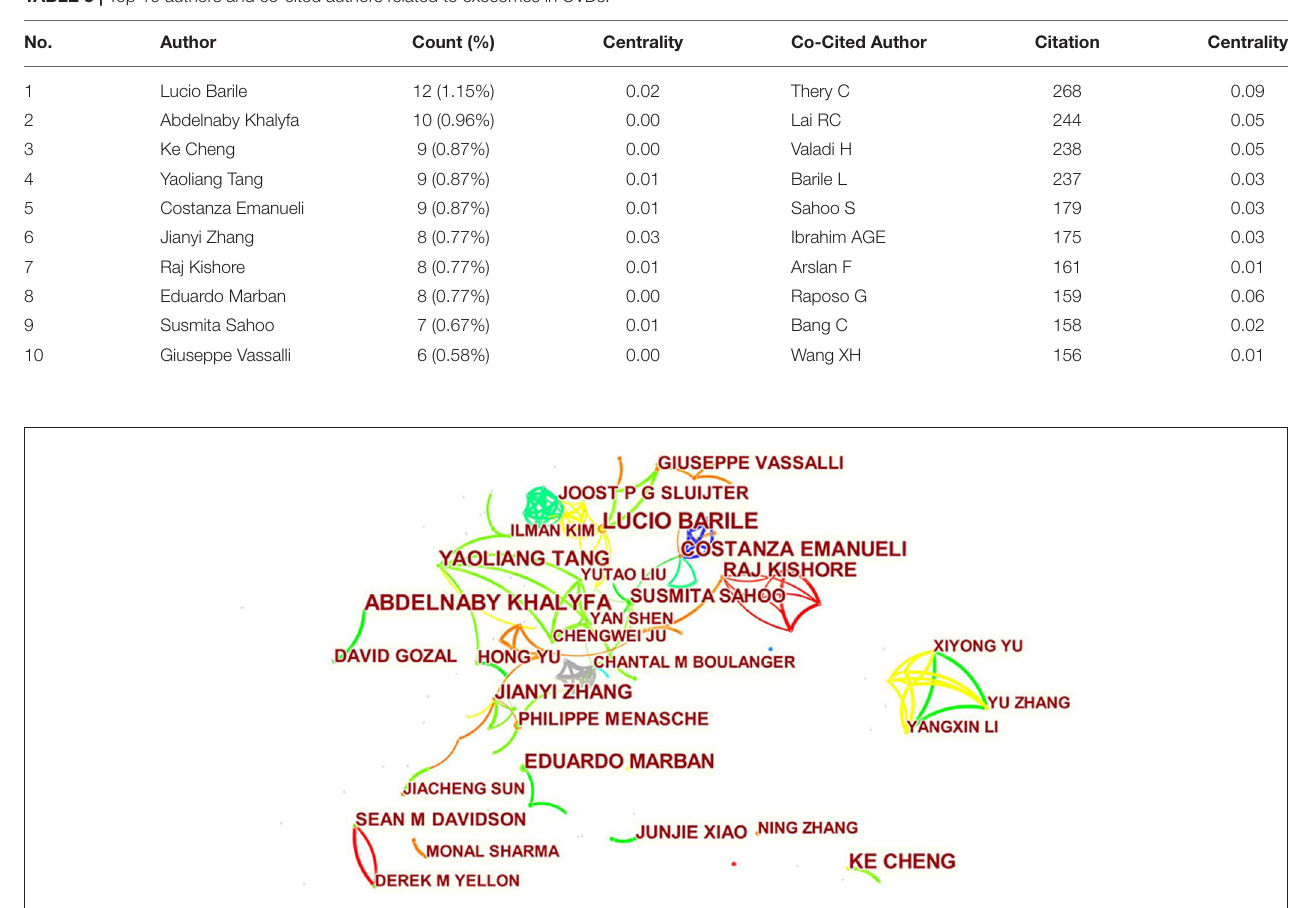
FIGURE 6 | CiteSpace visualization map of authors involved in exosomes in